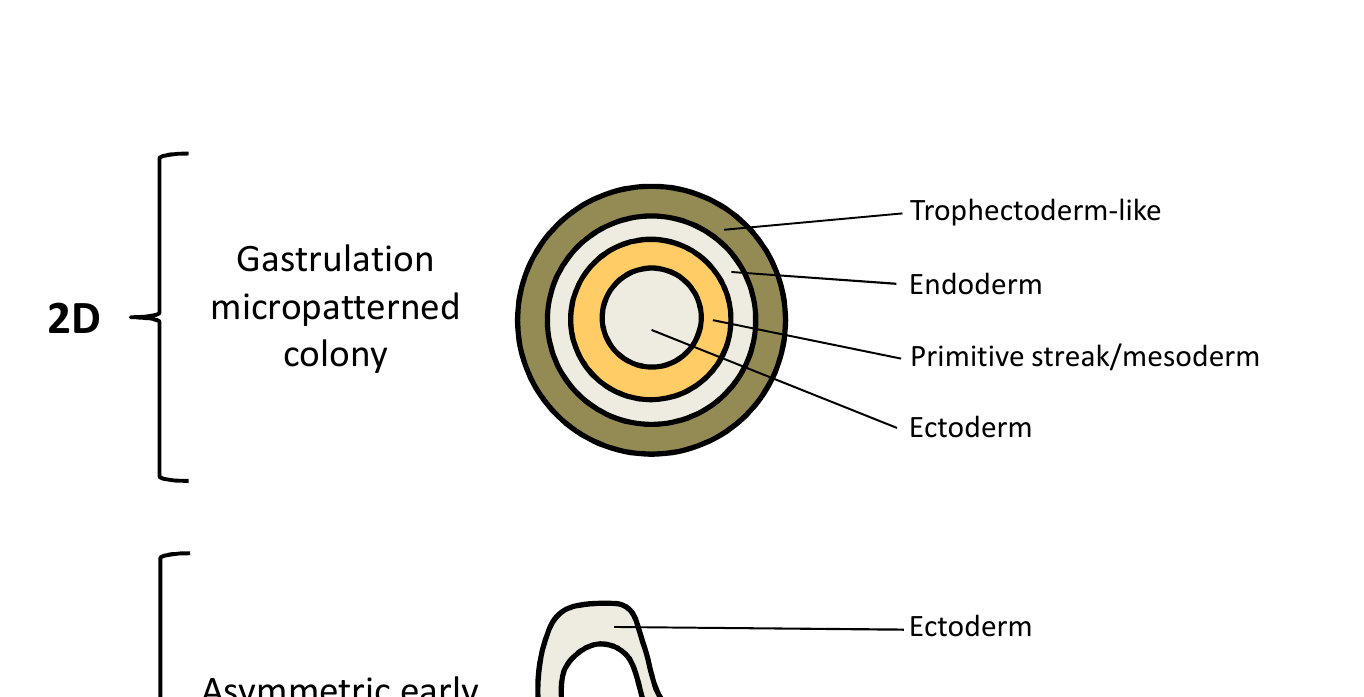
Figure 1. Human embryo models